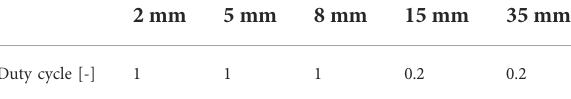
TABLE 3 Duty cycle (non-dimensional) for all reactor thicknesses, computed for k a = 0.1 m 2 g − 1